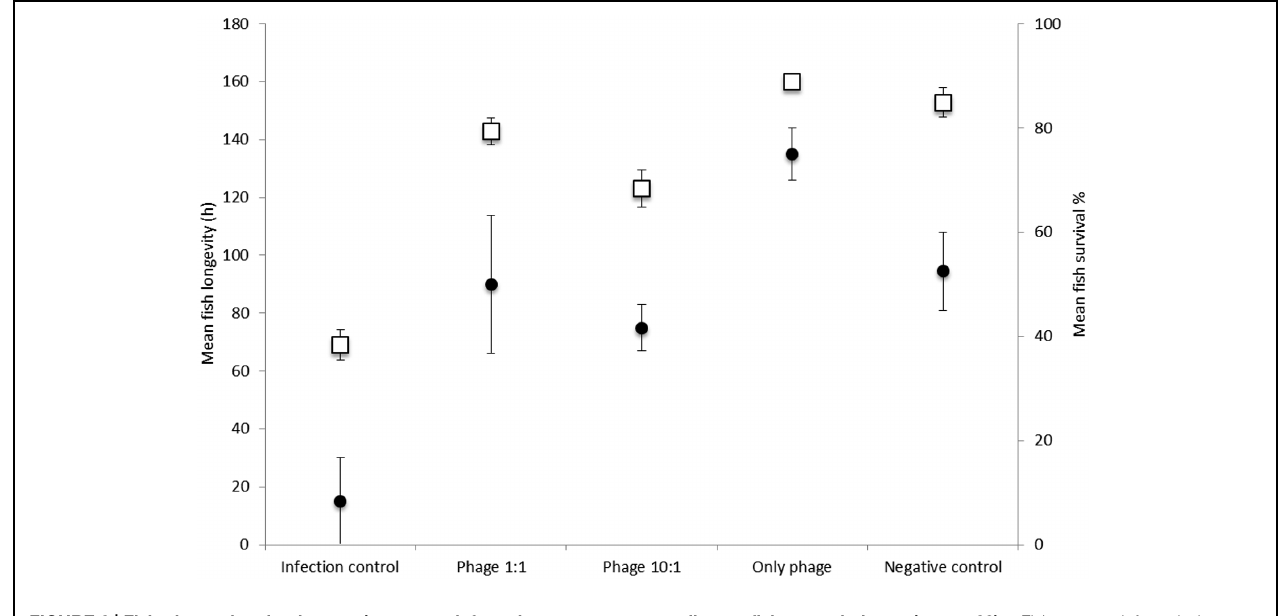
FIGURE 2 | Fish longevity in hours (squares, left axis; mean ± SE) and survival percentage (dots, right axis; mean ± SE) of rainbow trout after exposure to Flavobacterium columnare B185 and phage FCL-2 in three